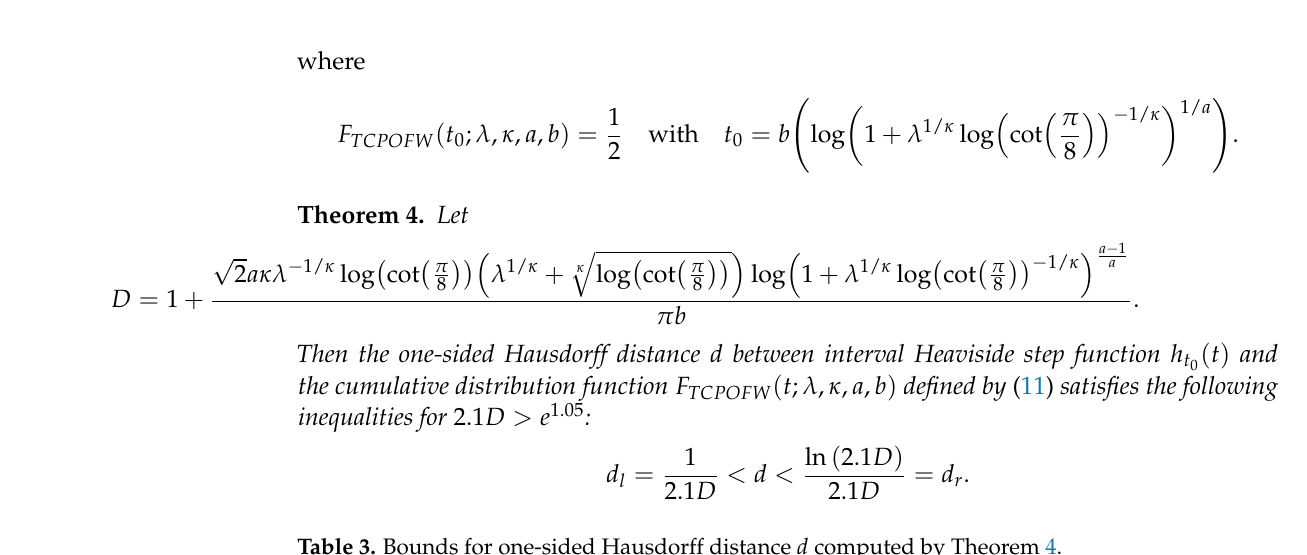
Table 3. Bounds for one-sided Hausdorff distance d computed by Theorem 4.